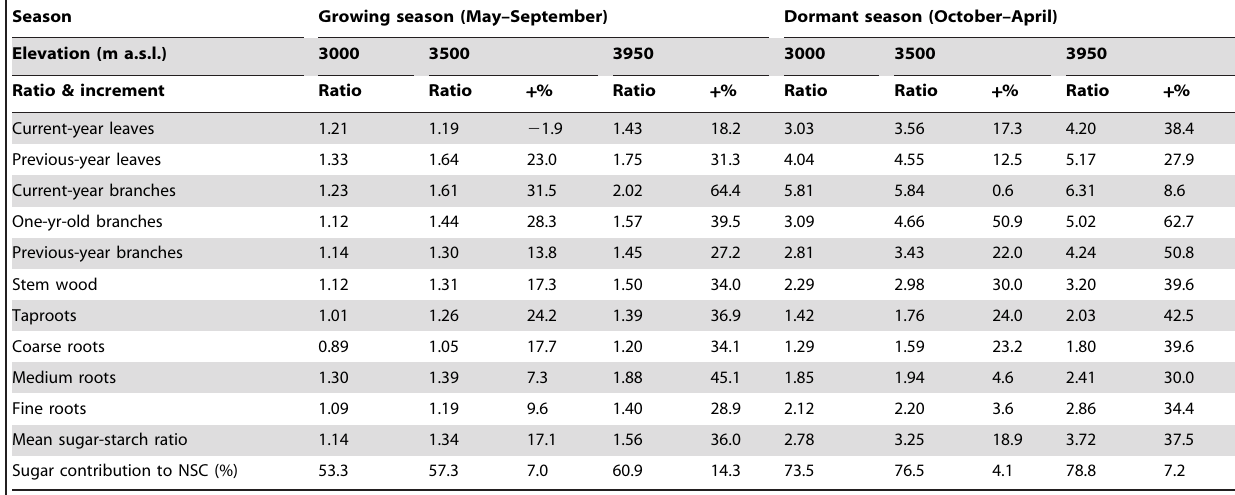
Table 3. Concentration ratios of total soluble sugars to starch (RSS) in tissues of Quercus aquifolioides shrubs grown at elevations of 3000 m, 3500 m, and 3950 m a.s.l. (the elevational limit) during the growing season (May–September) and the dormant season